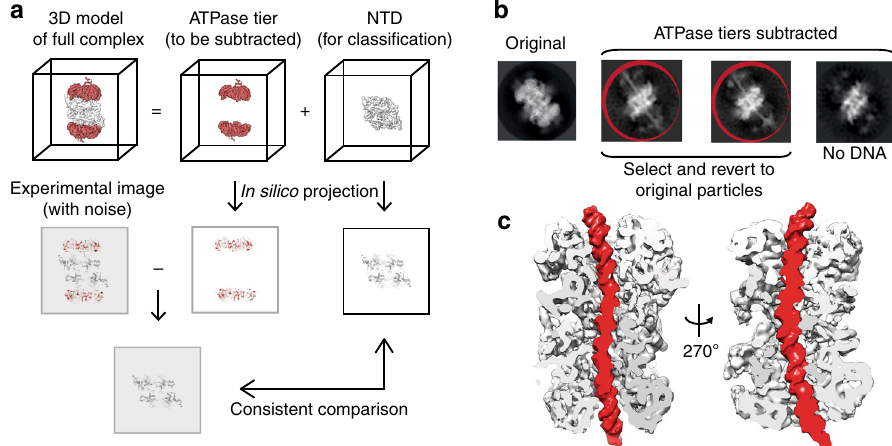
Fig. 3 Signal subtraction of ATPase motor allows structural characterization of the DNA-bound double hexamer. a Signal subtraction scheme, based on Bai et al. 27 . The full 3D model is composed of the AAA+ ATPase and N-terminal tiers. A mask was created for the ATPase tier, which was applied to the experimental images (particles) for subtraction. The remaining density corresponds to N-terminal tiers and DNA (if present) that would emanate from the channel. b Signal subtracted particles were subjected to 2D classi fi cation. Classes showing helical DNA density protruding from the N-terminal tiers were selected and reverted to their original full density before 3D re fi nement. c Cryo-EM map of the DNA-bound, unphosphorylated MCM double